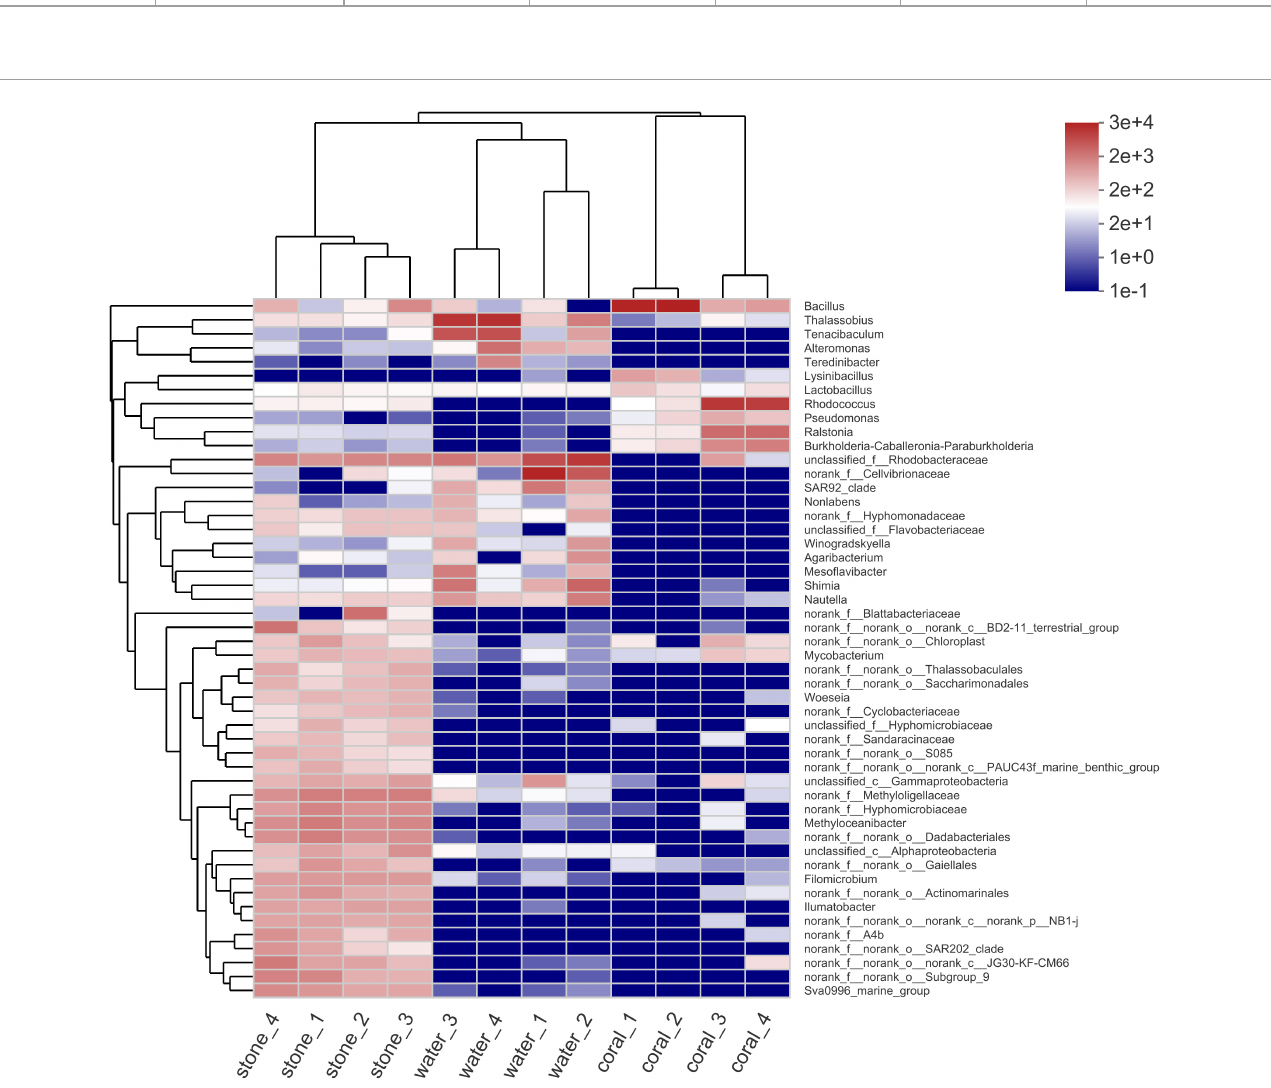
FIGURE5 Community species abundance clustering heatmap of coral culture system on the genus level. The horizontal clustering is sample information, and the vertical clustering is species information. The left clustering tree is the species clustering tree and the upper clustering tree is the sample clustering tree. The middle is the abundance